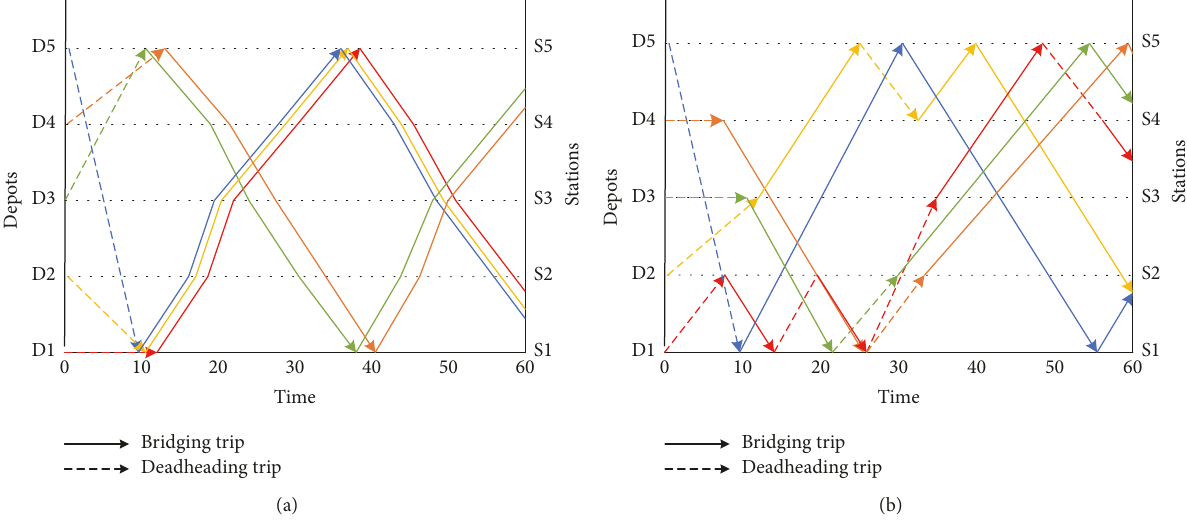
Figure 4: Comparing time space diagram of buses before and after optimization in illustrative example.